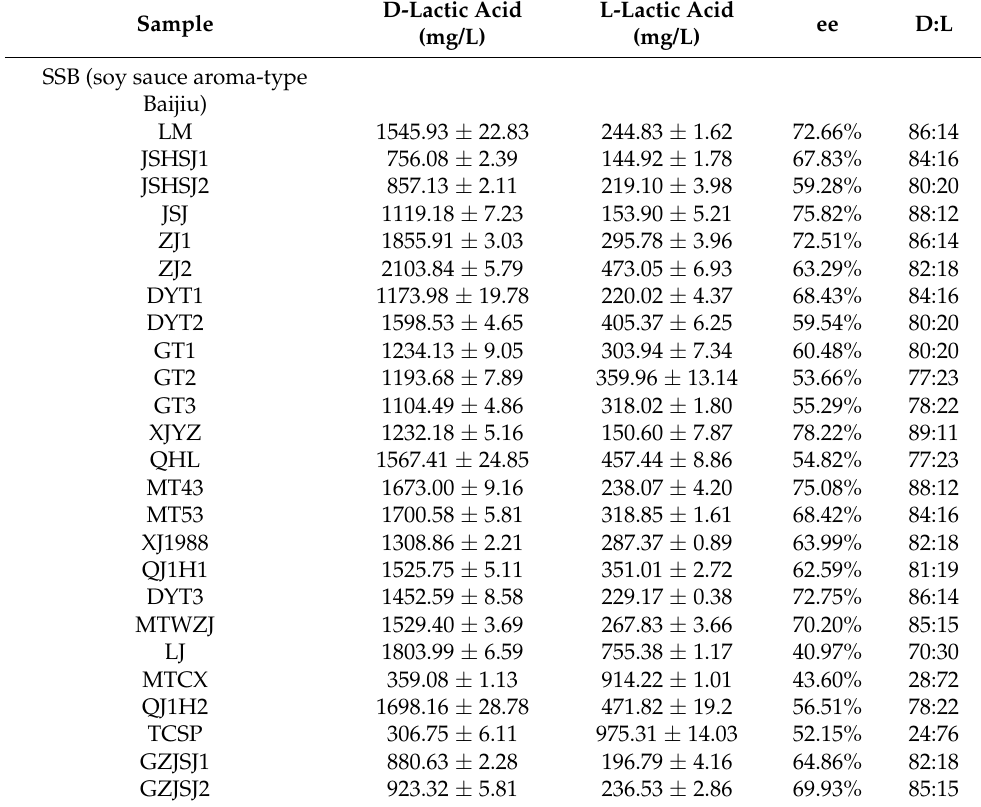
Table 2. The concentration and ratio of lactic acid enantiomers in the three major Baijiu